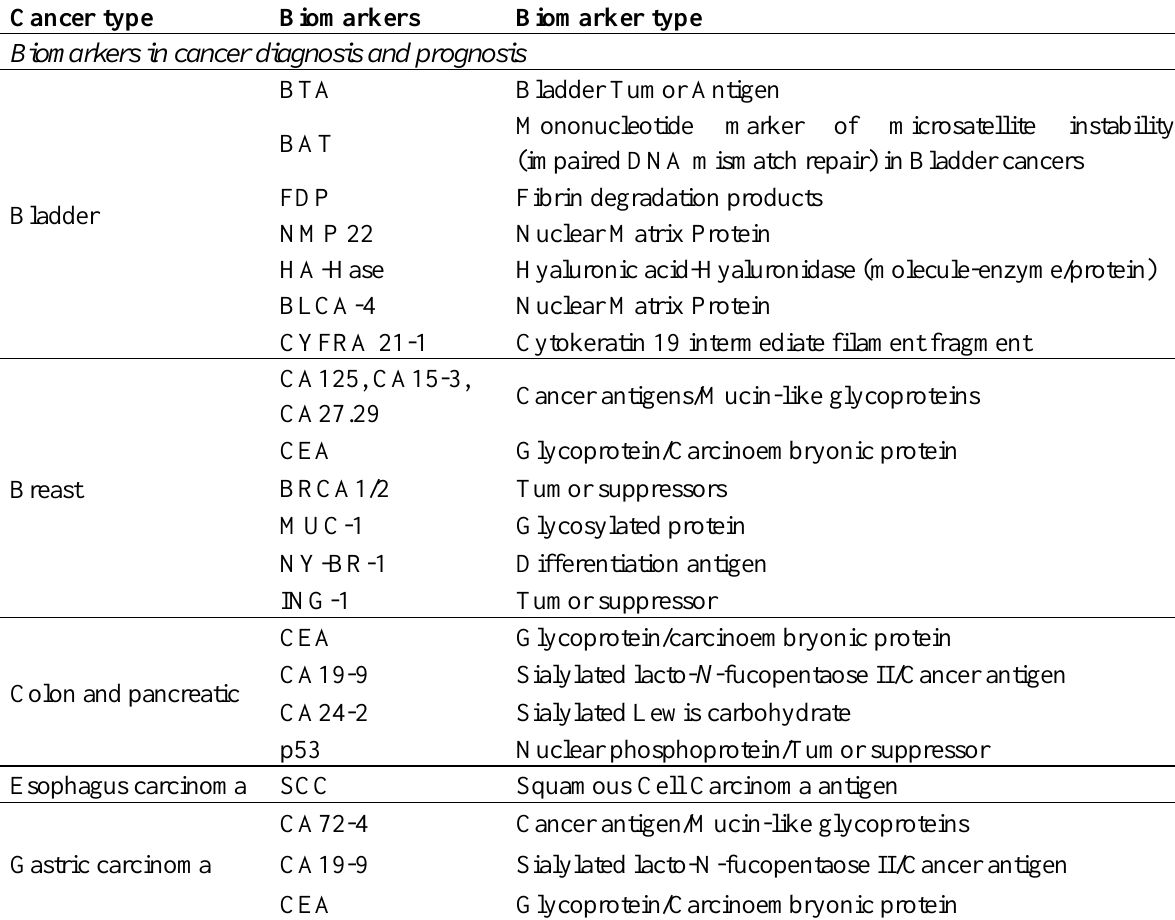
Table 2. Biomarkers used in cancer diagnosis and prognosis and psychiatry